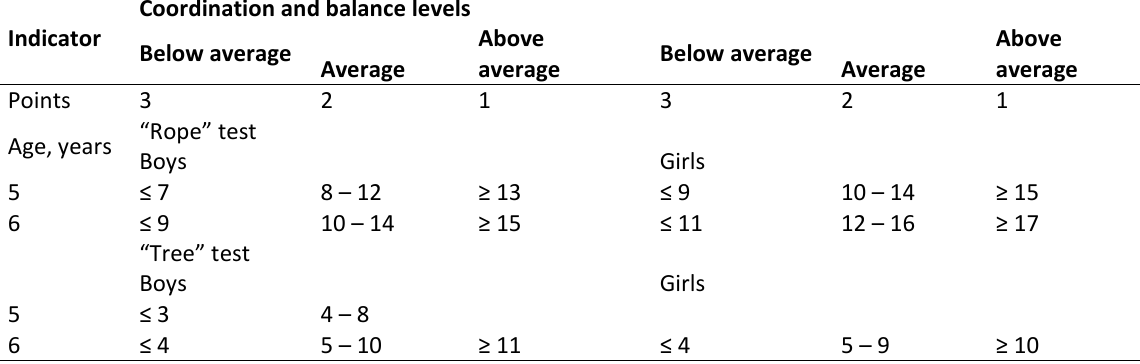
Table 3. Assessment of coordination tests’ results (seconds)